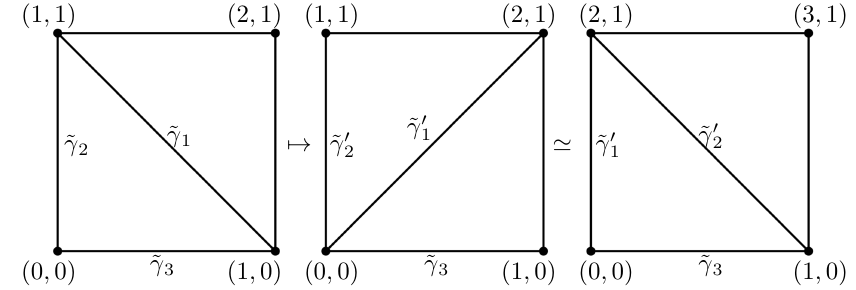
ˆ T to restore the initial 1 and then act with = ˜ γ (1) as the diagonal which is to be unflipped 2 1